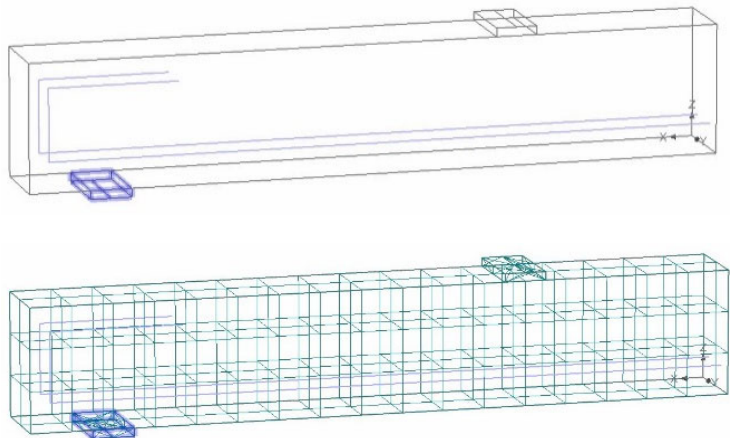
Figure 6. Beam modeling and its meshing. The relationship between one solid element and the other solid elements was modeled and defined by the ‘contacts’ on each ‘surface’ which were connected to each other.